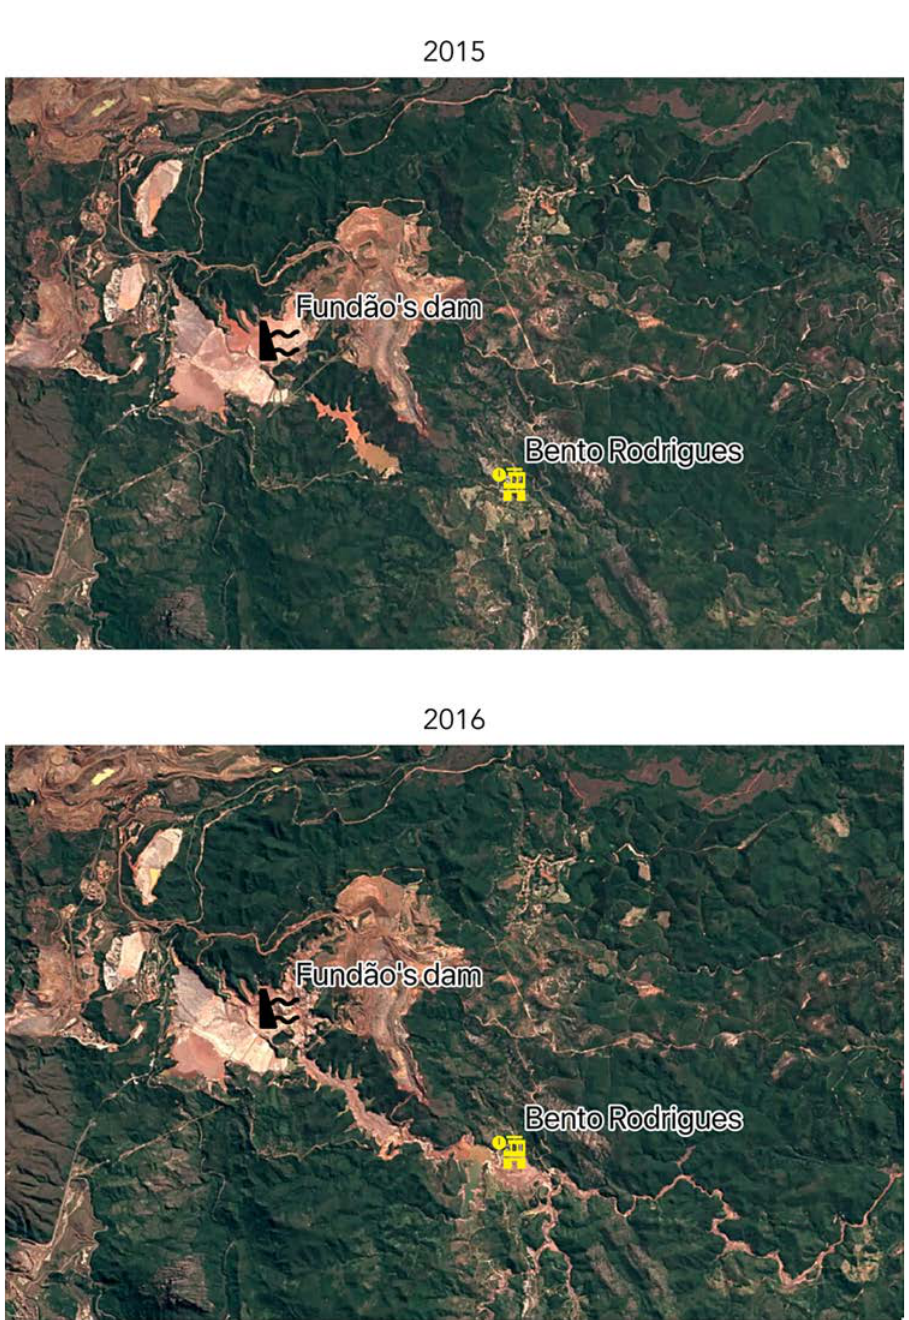
Figure 3. Timelapse of satellite imagery from Mariana before and after the dam collapse – 2015- 2016 Source: the author, with data from Google Earth Engine Timelapse